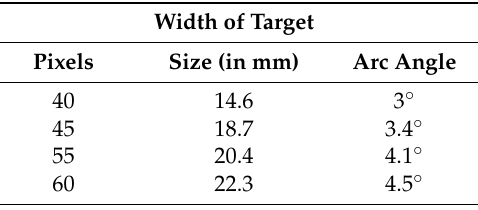
Table 2. Details on pointing targets.